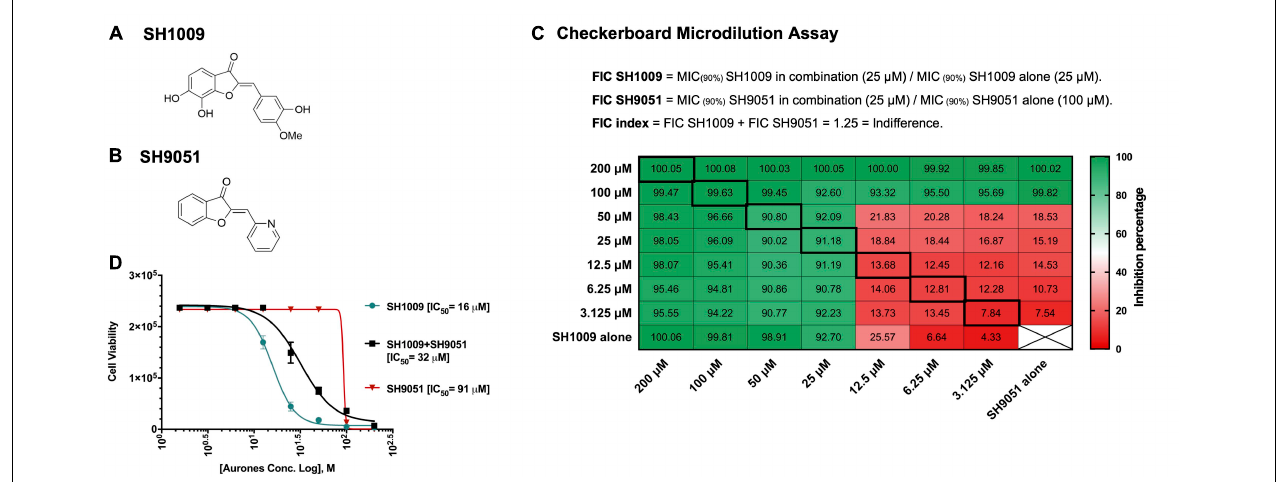
FIGURE 1 | Antifungal assessments of aurones SH1009 and SH9051 against C. albicans SC5314 strain. (A) The chemical structures of aurones SH1009 and (B) SH9051. (C) The checkerboard microdilution assay in 96-well plate format. Each cell represents the percent inhibition of C. albicans (0.5–2.5 × 10 3 CFU/mL) growth during aurone SH9051 and SH1009 treatments (3.125–200 µ M) in RPMI-1640 medium for 24 h at 35 o C either in combination or alone. (D) Graphing the non-linear regression of the cell viability readings based on the fluorescence intensity of PrestoBlue reagent using GraphPad Software to calculate the IC 50 (concentration causing 50% growth inhibition) values of SH1009, SH9051, and SH1009 + SH9051 combination after transforming the molar concentrations of the aurones into logarithmic form. The cell viability readings of SH1009 + SH9051 combination were obtained from the bolded squares on the checkerboard